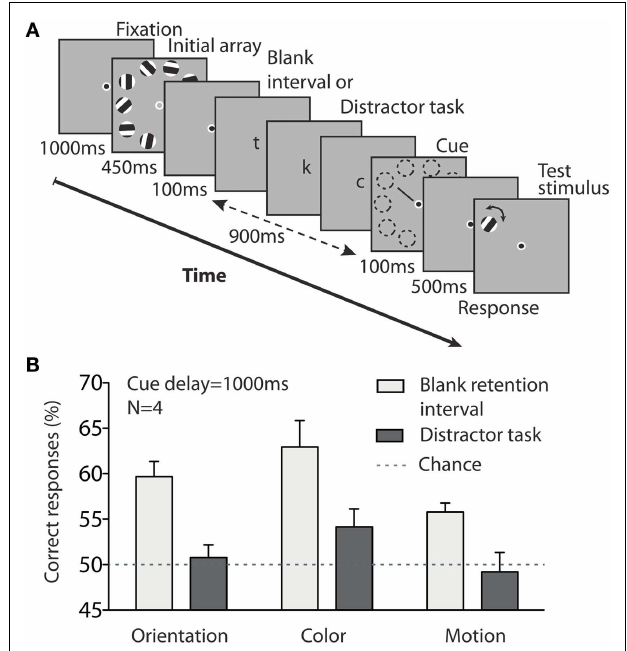
FIGURE 4 | Experiment 2 tested memory for color, form, and motion for a cue delay of 1000ms, with or without manipulation of attention. (A) On trials that contained a distractor task, participants had to detect targets in a stream of rapidly presented letters during the cue delay. A sound warned them in advance about what type of trial would occur. (B) Having to perform an attention-demanding task during the retention interval disrupted memory. Error bars denote standard errors of the mean, N =